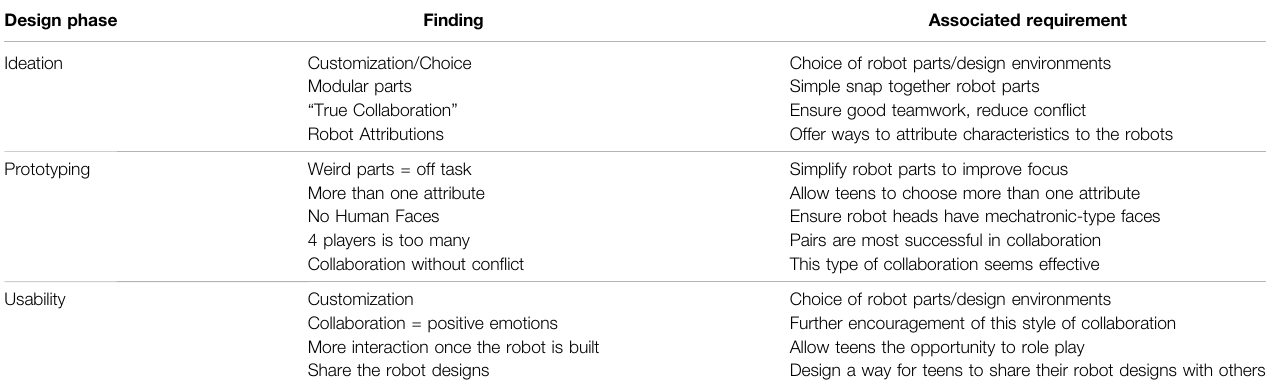
TABLE 2 | Design principles and requirements resulting from the three design